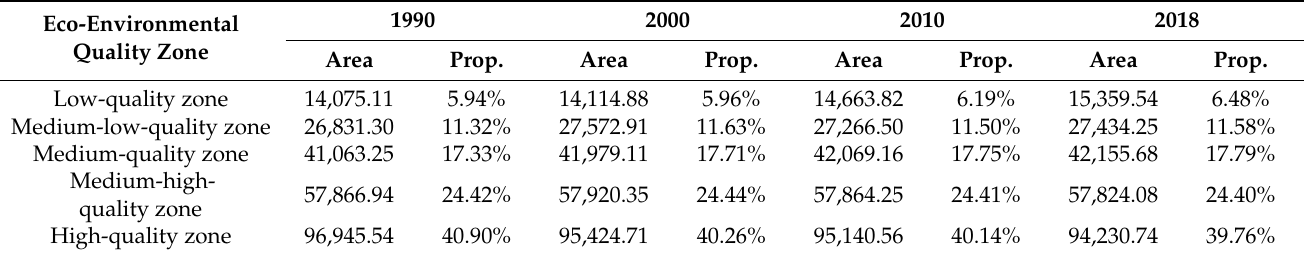
Table 4. Areas (km 2 ) and proportions (%, “Prop.”) of eco-environmental quality zones in Guangxi, China, during